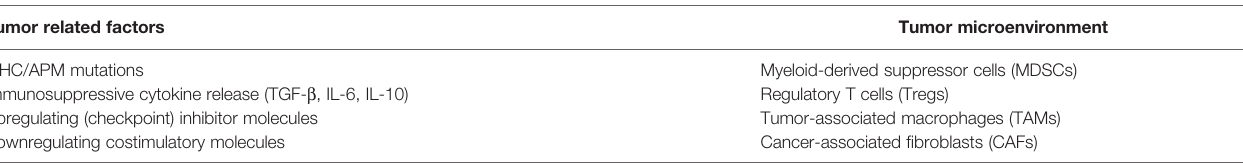
TABLE 1 | Methods of immune evasion. Tumor related factors